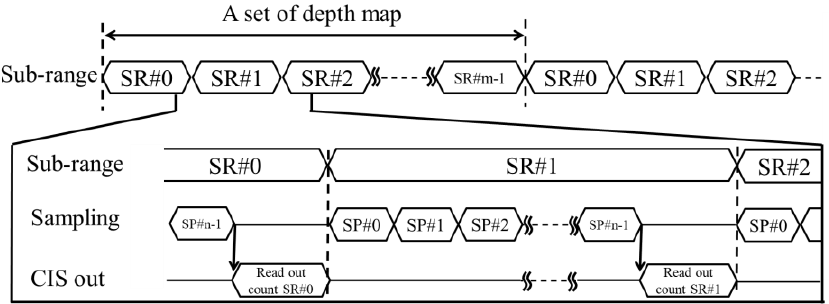
Figure 6. A timing diagram describing a relation between subrange sequence, light pulse sampling, and CIS output.